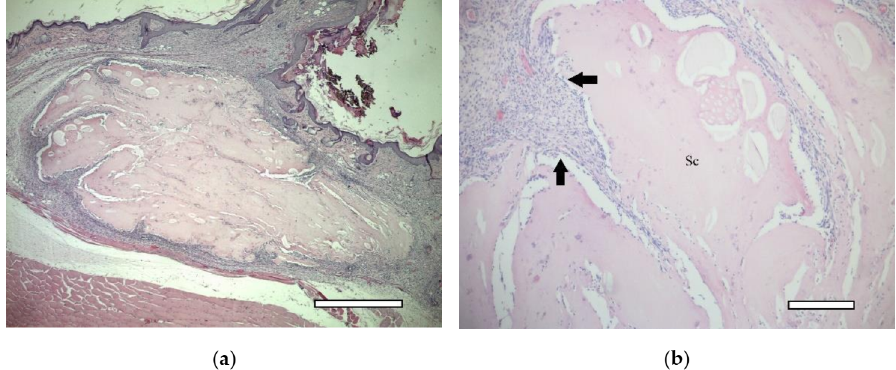
Figure 18. 3rd group (dECM and MSC), 1 week. Connective tissue capsule. Staining with hematoxylin and eosin. Scaffold region (Sc) ( a ) objective lens × 2.5, scale bar—800 µ m; ( b ) objective lens × 10, scale bar—200 µ m.